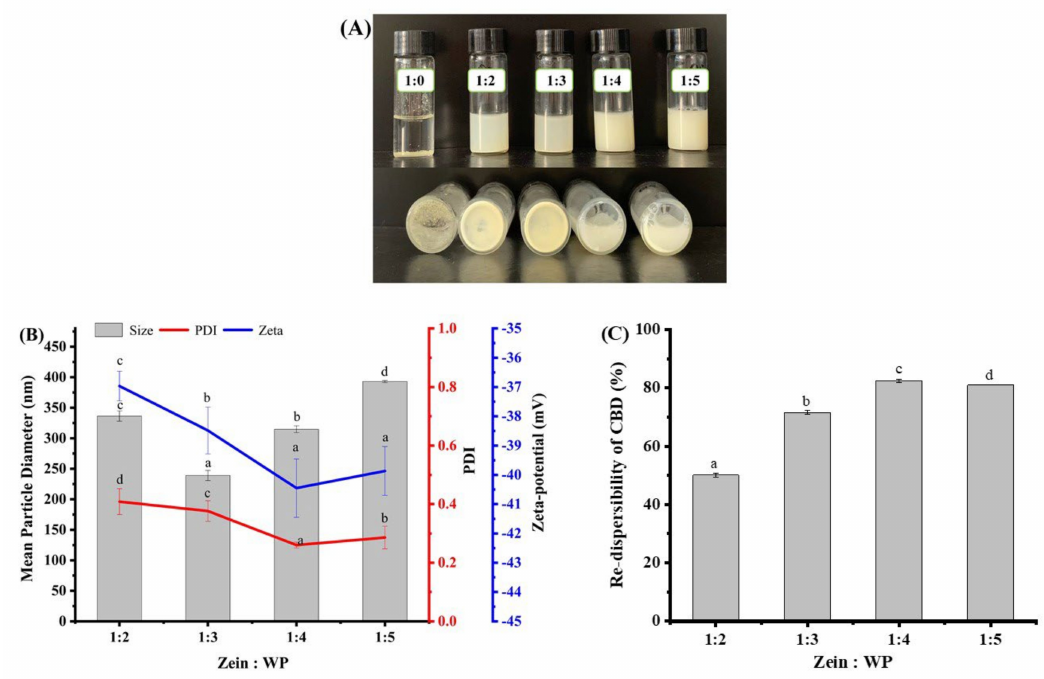
Figure 3. Re-dispersibility of freeze-dried CBD-loaded nanoparticles as demonstrated by nanoparticle appearance ( A ), mean particle diameter, PDI, zeta-potential ( B ), and re-dispersibility of CBD ( C ). Note: different lowercase letters indicate the significant difference ( p < 0.05) between samples at different biopolymer